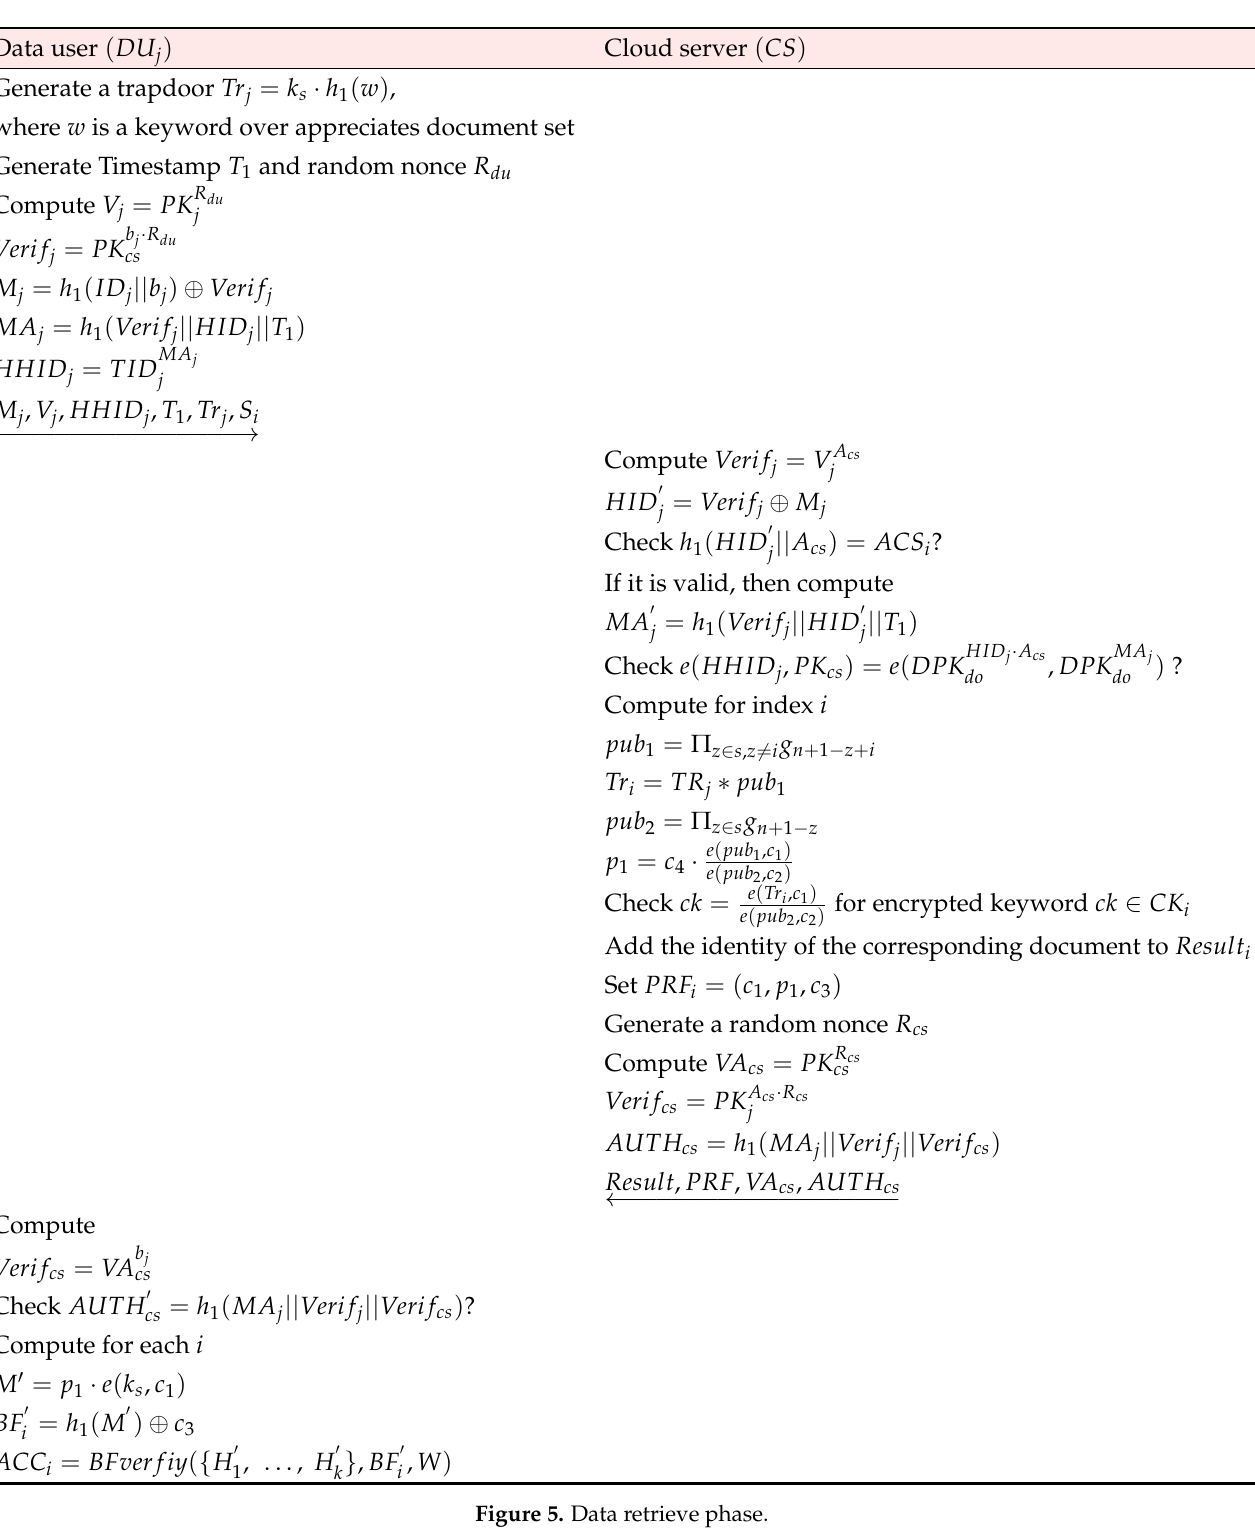
Figure 5. Data retrieve